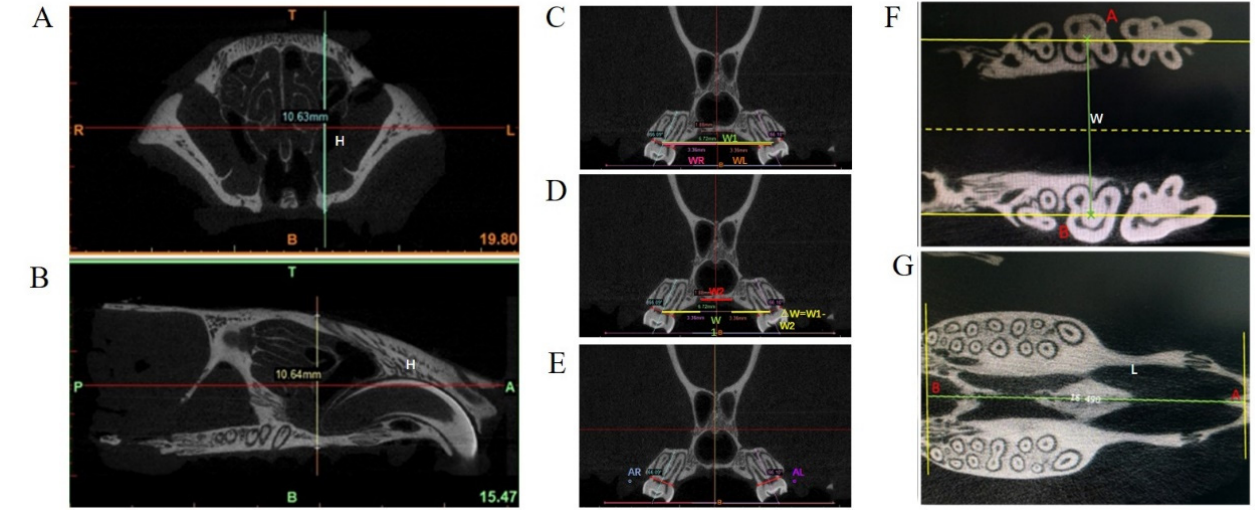
Figure 2. Parameters to characterize the maxillofacial growth. ( A , B ) The maximum perpendicular distance on the coronal and sagittal planes of the front maxillary suture to the alveolar crest was defined as the height of the maxilla (H). ( C ) Dental arch width (W1) was defined as the distance between the midpoints of the line connecting buccal and palatal CEJs of the teeth on both sides, and use the intersection of this line and central axis (crossing cranial fissure, nasal septum, and palatine fissure) as the separation to measure the right and left dental arch width (WR and WL). ( D ) The palatine bone width on the layer (W2) was measured to demonstrate the horizontal distance of the great palatine neurovascular bundles on both sides; alveolar bone width ( Δ W = W1 − W2) was the difference between the dental arch width and palatine bone width, which could represent the growth of alveolar bone. ( E ) The right and left inclination angles of the dental arch (AR° and AL°) were the intersection angle of the occlusion plane and the long axis of the tooth. ( F ) On the layer that showed the cementoenamel junction (CEJ), the distance between the midpoints of the buccal and palatal surface of the second molar was defined as the width of the maxilla ( W). ( G ) The perpendicular distance between the anterior point of incisive foramen to the line connecting two posterior points of the distal root of the third molars was defined as the length of the maxilla (L). The other parameters were measured by Mimics 16.0 (Materialise; Leuven, Belgium).